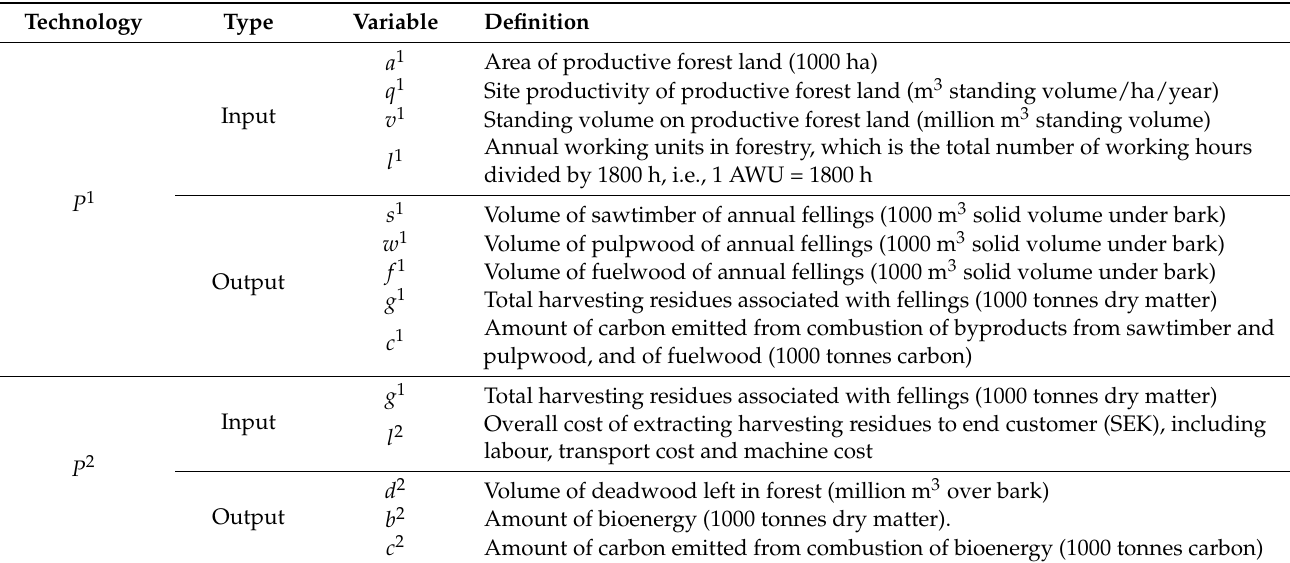
Table A1. Input and output variables for the network DEA model.